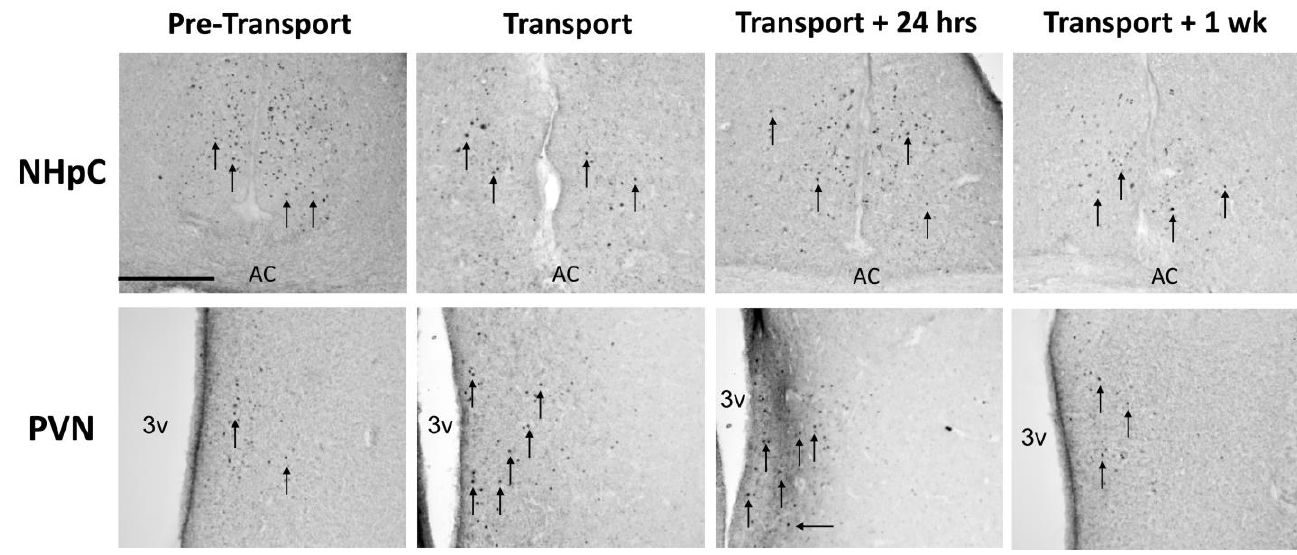
Figure 3. Representative photomicrographs of fos-ir. Top row: no differences in fos-ir were observed in the NHpC at any time point assessed. Bottom row: the number of fos-ir nuclei in the PVN increased with Transportation and continued to show increased numbers for 24 h before returning to Pre-transport levels. Arrows = fos-ir nuclei. AC = anterior commissure. 3v = third ventricle. Bar = 100 um. Arrows point to representative fos-ir.